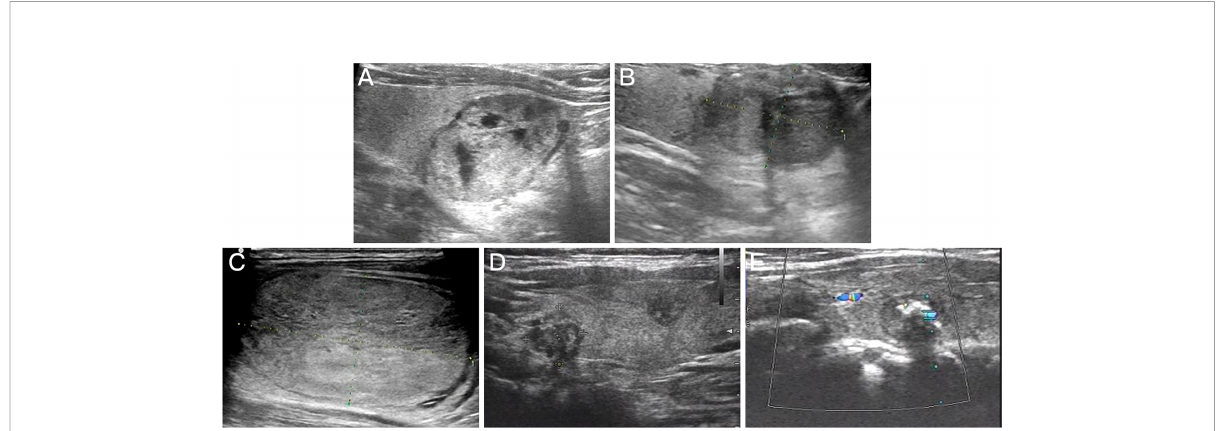
FIGURE 2 Preoperative ultrasound images for thyroid nodules with different pathologic types. (A) Follicular thyroid adenoma. (B) Follicular variant papillary thyroid carcinoma. (C) Follicular thyroid carcinoma. (D) Multifocal papillary thyroid carcinoma. (E) medullary